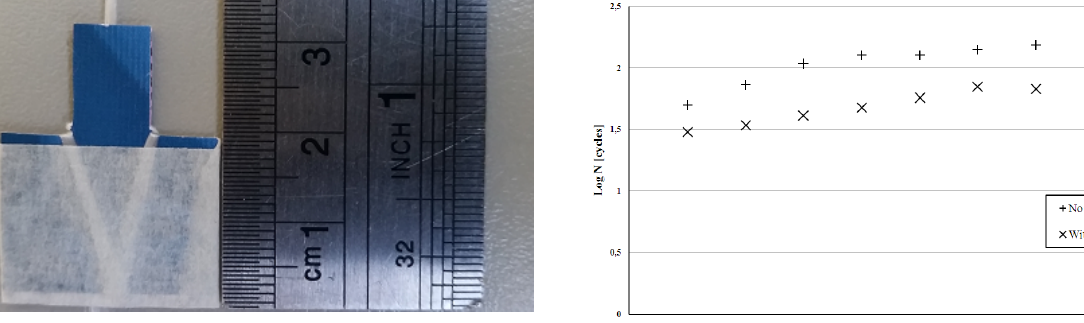
Figure 1. Sandwich-type terminals.